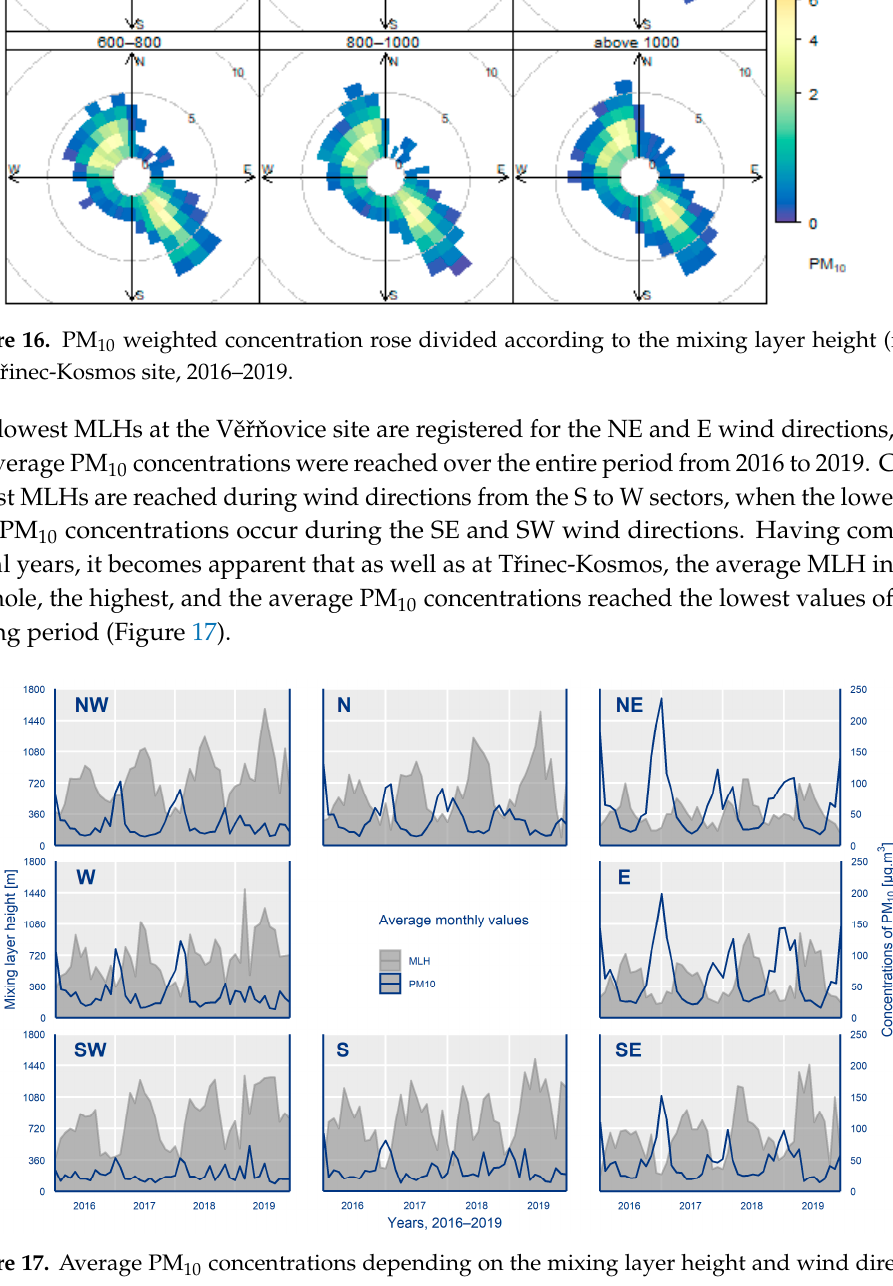
Figure 17. Average PM 10 concentrations depending on the mixing layer height and wind direction, the Vˇeˇrˇnovice site, the V ěřň ovice site, 2016–2019.